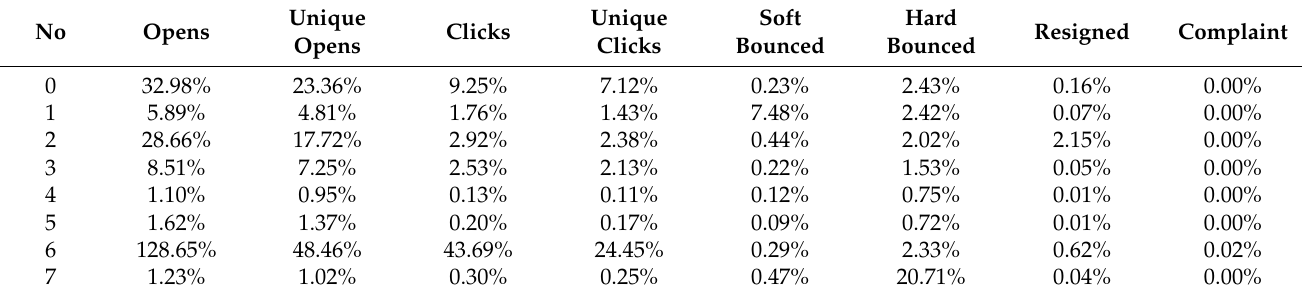
Table 2. Cluster